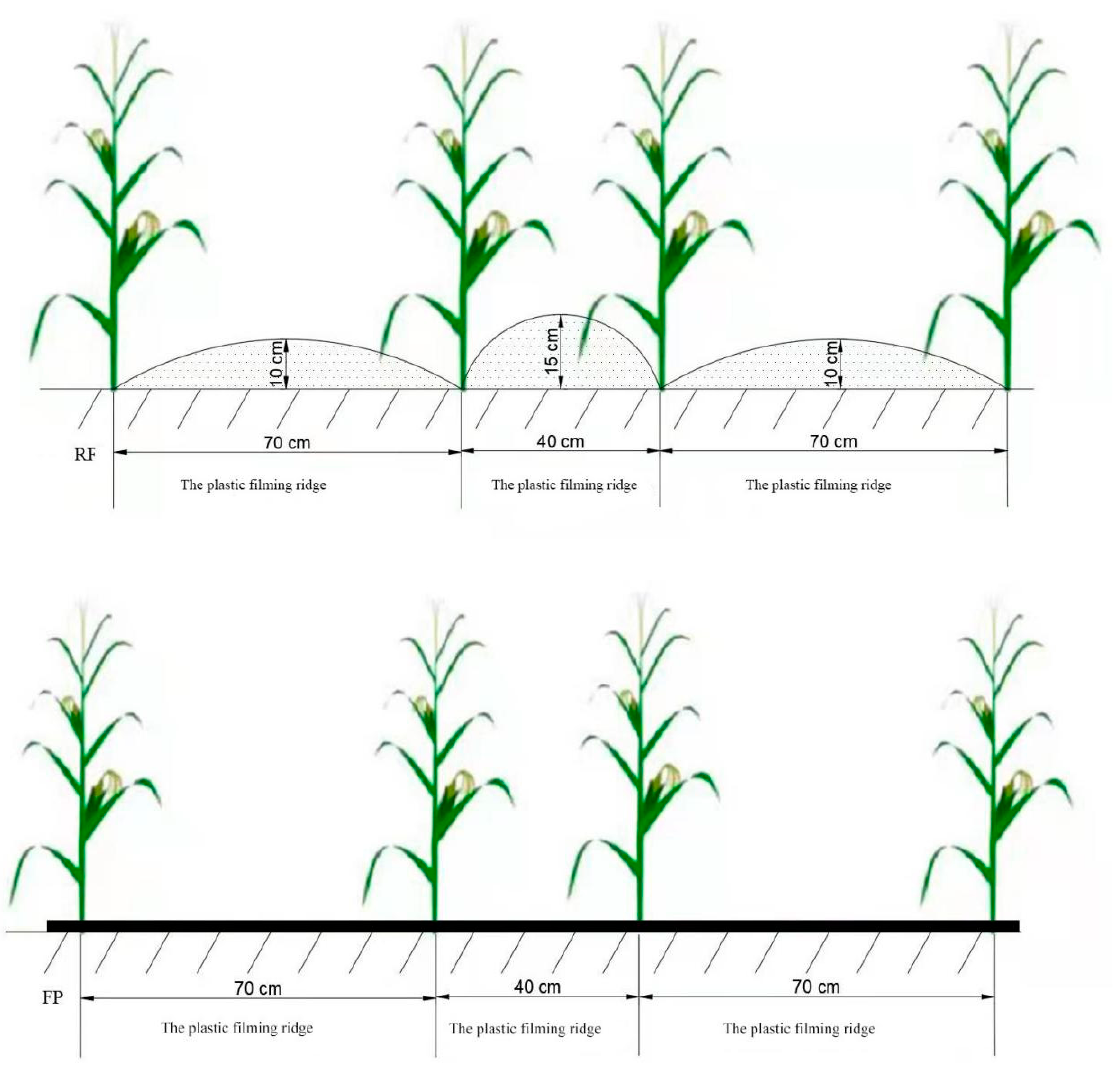
Figure 2. Schematic diagram of the field layout where maize plants were separated by alternating distance. The top shows RF (ridge–furrow plastic film mulching) with wide (70 cm) and narrow (40 cm) plastic film-mulched ridges of 10 cm and 15 cm height, respectively. The bottom shows FP, (flat planting with plastic film mulching) with the same plant distance.